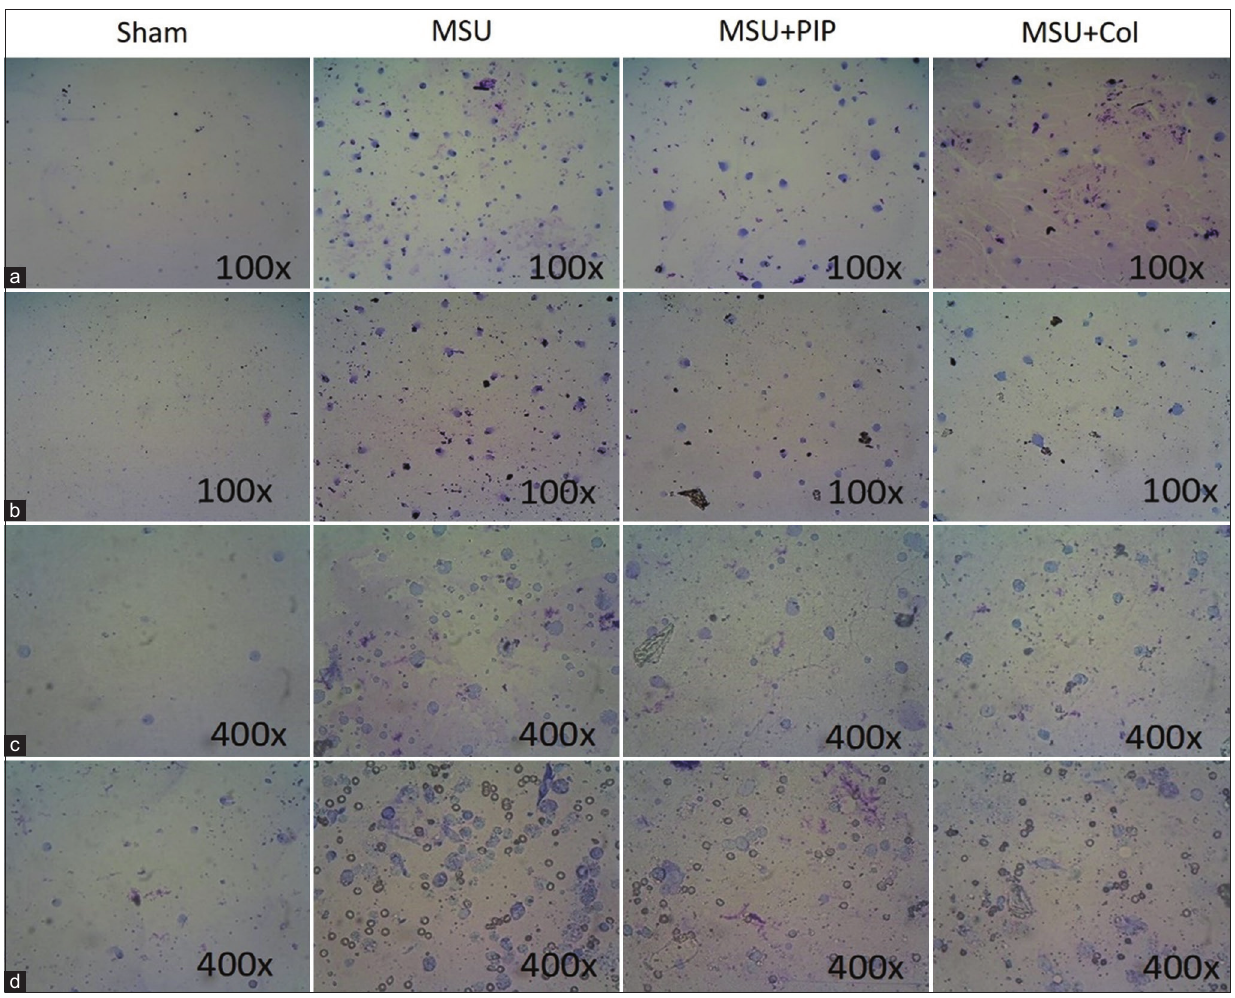
Fig ure-4: Piperine bioactivity in the inhibition of leukocyte exudation in edema of rat plantar due to monosodium urate injection. (a and c) Giemsa staining of protocol I rat paw exudate. (b and d) Giemsa staining of protocol II rat paw exudate. (a) Resident macrophages and monocytes in edema 24 h post-injection. (b) Resident macrophages and monocytes in edema 72 h after injection. (c) Neutrophil exudation 24 h after injection. (d) Neutrophil exudation 72 h